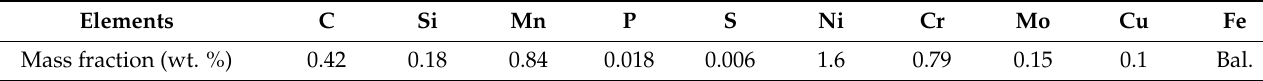
Figure 2. GB map of the initial specimen. Table 1. Chemical compositions of the studied steel (mass fraction, %).